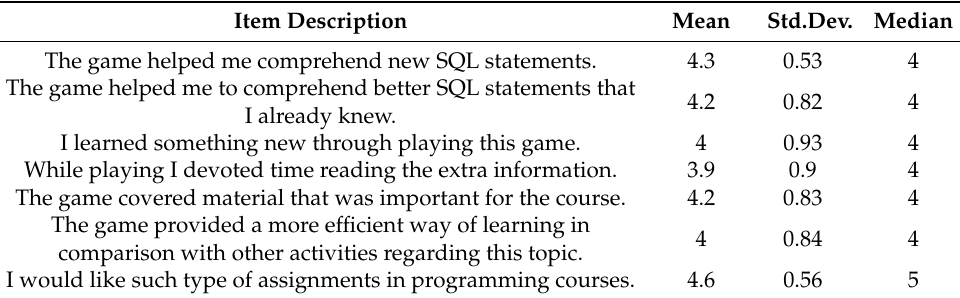
Table 4. Results on perceived short-term learning.